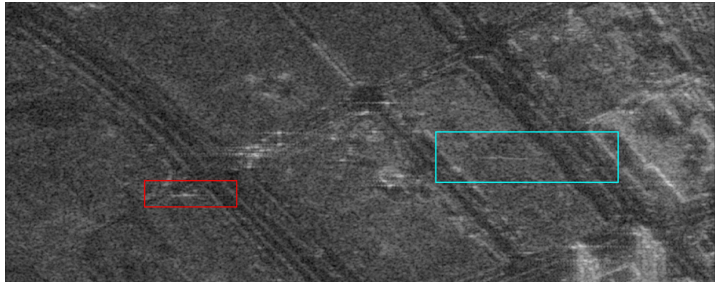
Figure 22. The 18th subaperture image in 100 image sequence. The reference clutter is denoted with a red box, and the blue box denotes a moving target